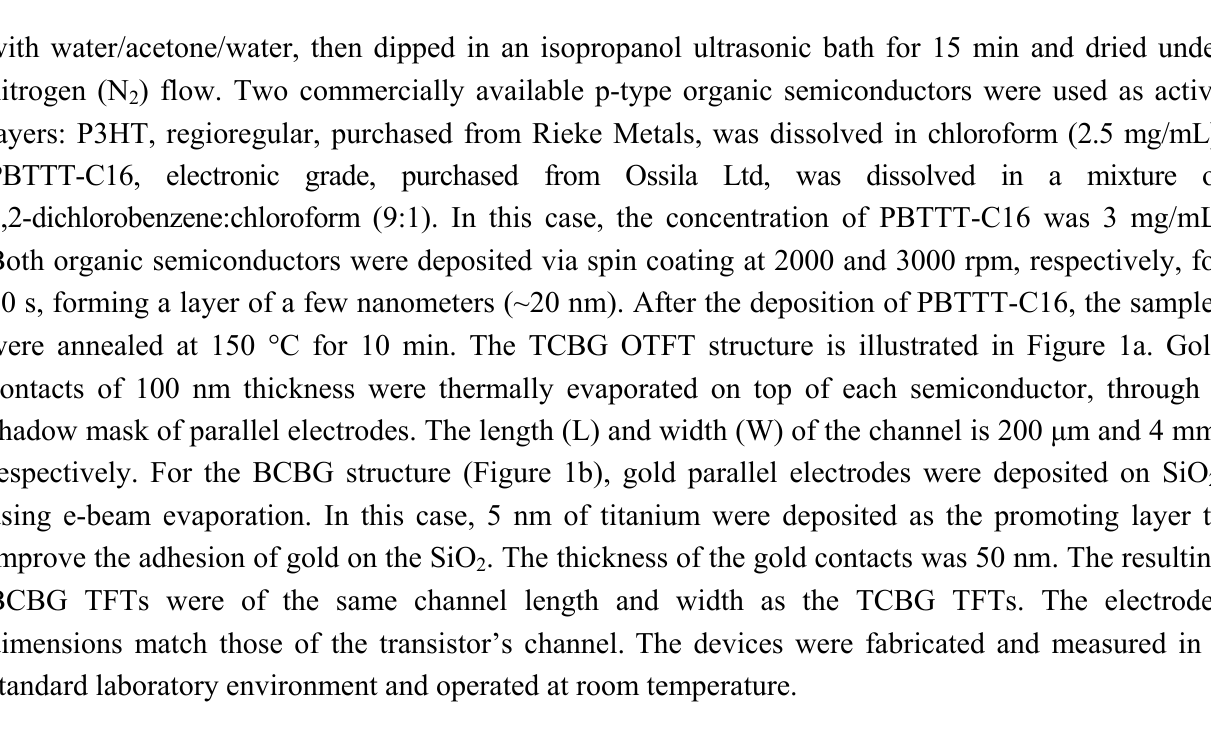
Figure 1. Schematic illustration of ( a ) top-contact bottom-gate (TCBG) ( b ) bottom-contact bottom-gate (BCBG) organic thin film transistors